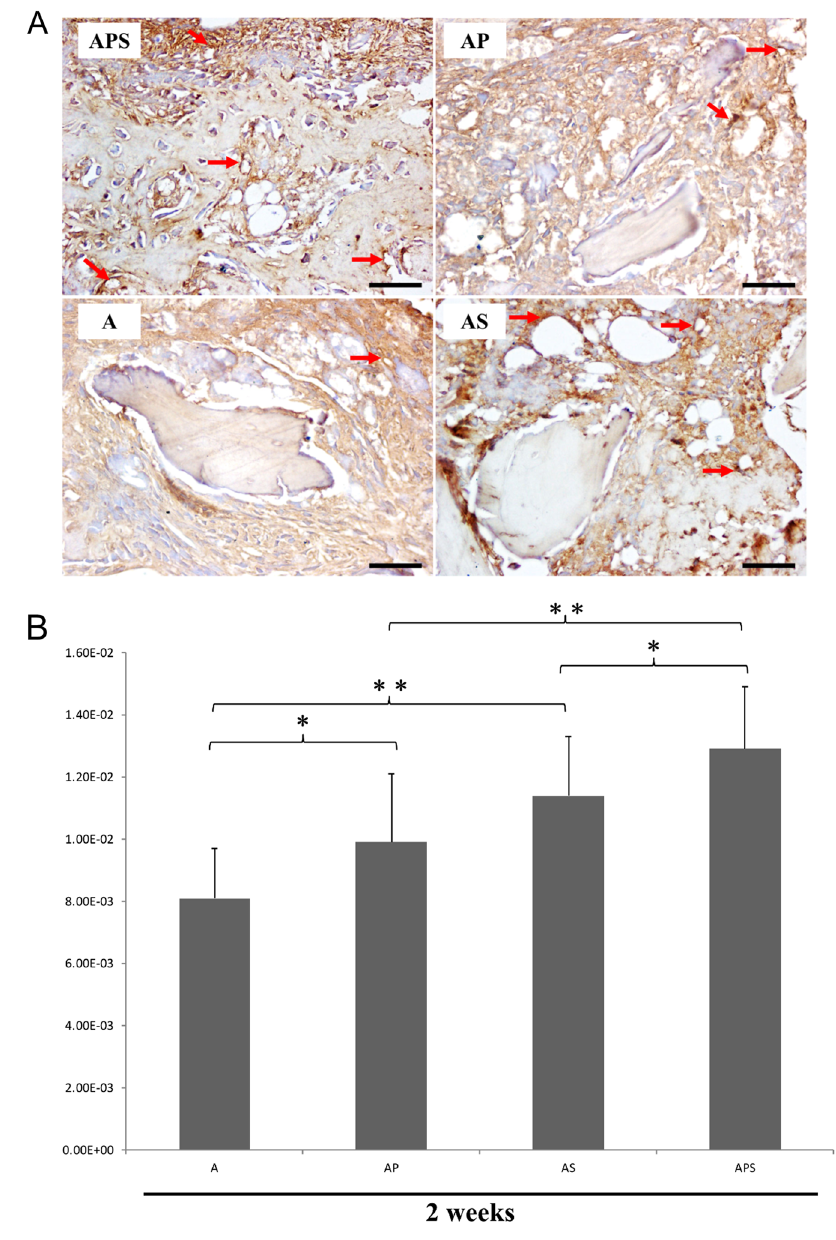
Fig. 4 A Immunohistochemical detection of CD34 revealing neovascularization in the A, AP, AS, and APS groups at 2 weeks. Original magni fi cation, ×400. Arrow, nascent blood vessels. Bar size, 50 μ m. B Quantitative analysis of CD34-dependent vessel density in four groups by the IPP software. * p <